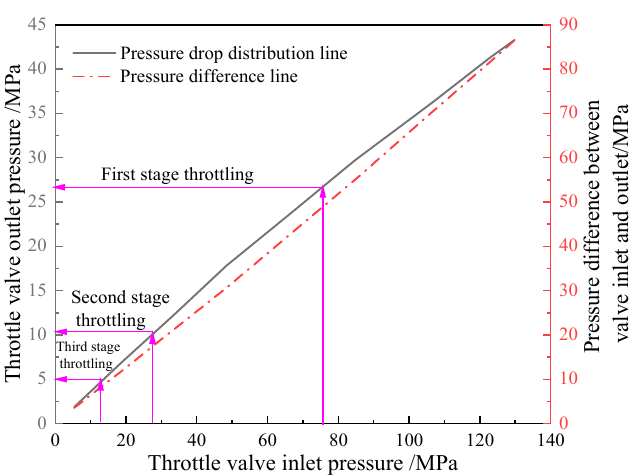
Figure 5. Throttle outlet pressure and pressure difference under different throttle inlet pressure con- ditions. Table 8. Optimized throttling process parameters and hydrate formation temperature for wells L004-X1 and L016-H1.